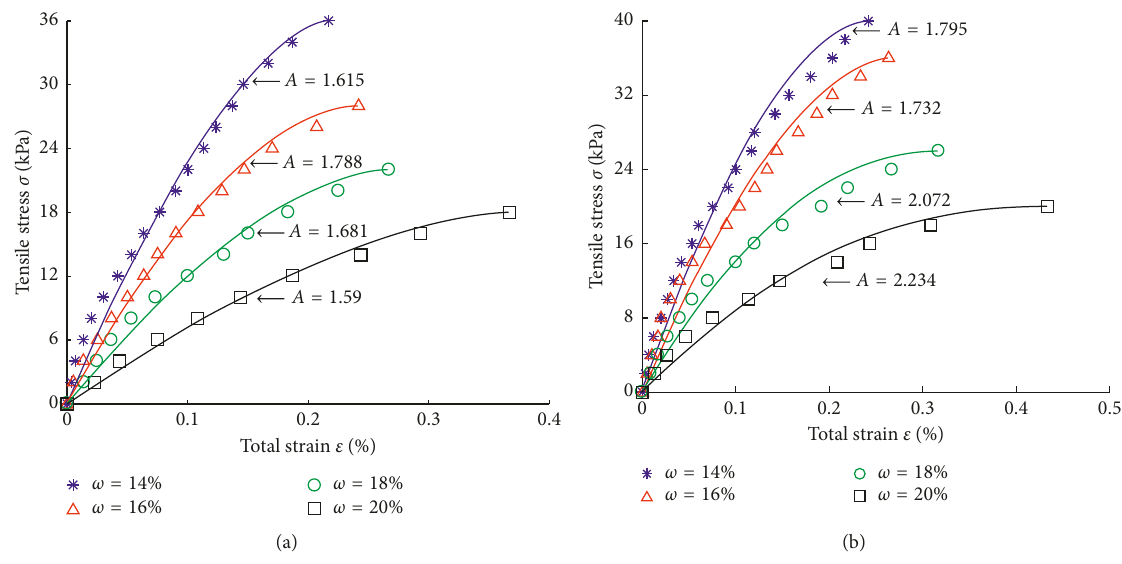
Figure 4: Direct tensile test σ × ε curves at different water contents: (a) ρ